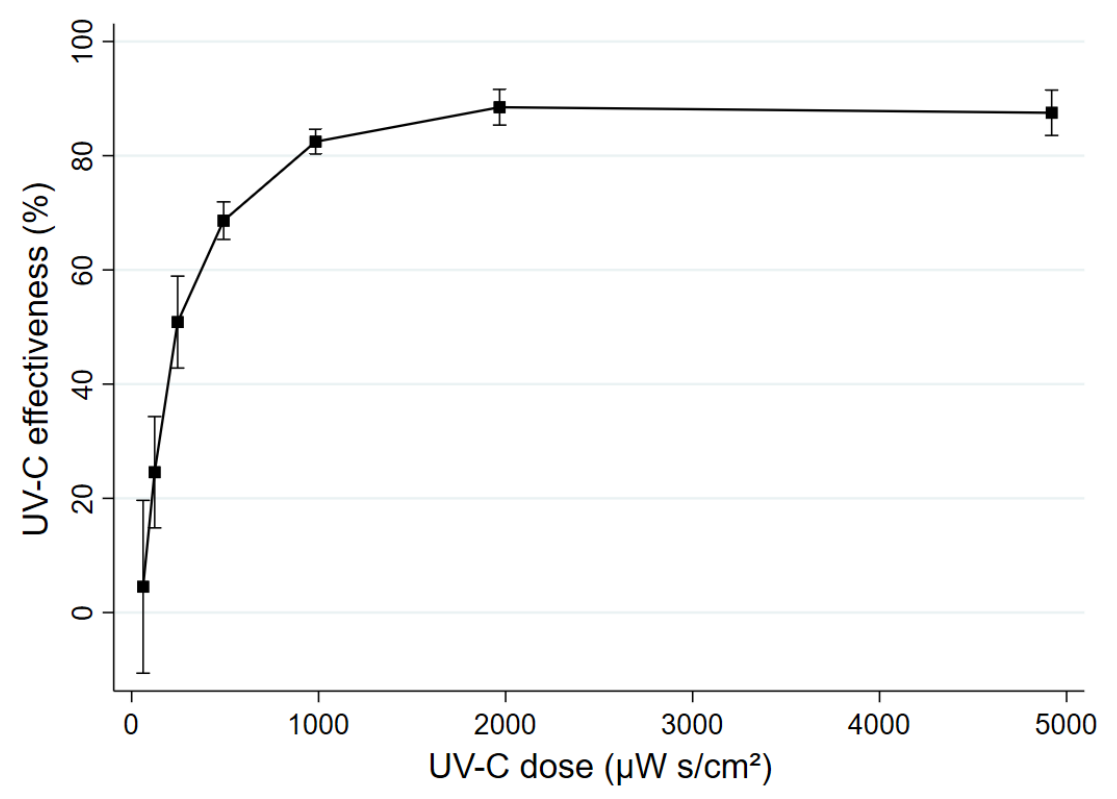
Figure 2. Mean UV-C effectiveness for airborne Pa AUST-02 at 60% RH by dose. Error bars are 95% confidence intervals.